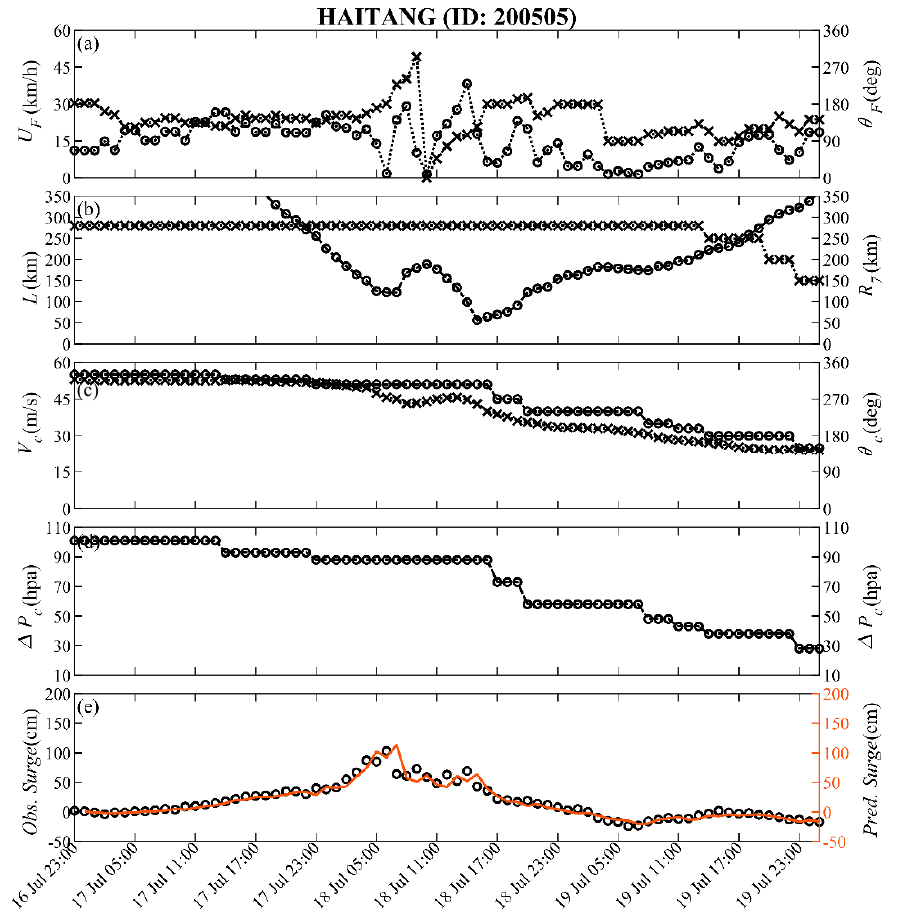
Figure 4. Temporal variations of typhoon parameters and storm surge at Longdong during Haitang event (validation): ( a ) forward speed (circle) and forward angle (cross); ( b ) relative distance (circle) and radius of typhoon (cross); ( c ) wind speed (circle) and relative angle (cross); ( d ) central pressure deficit (circle); ( e ) observed (circle) and predicted (red lines) storm surges. Table 4. Assessment of di ff erent lead-time surge predictions during Haitang event (validation). Lead Time